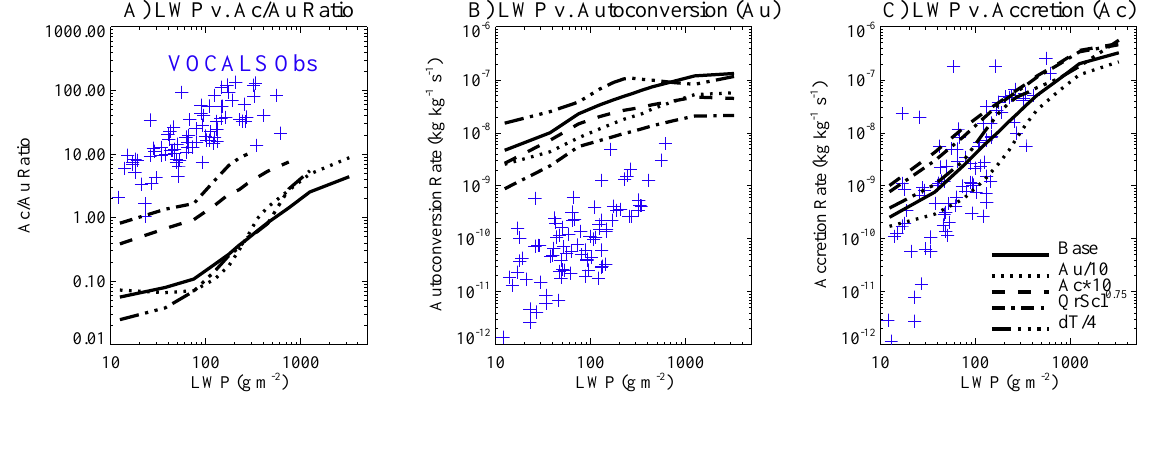
Figure 8. Global averages of vertically averaged (A) Accretion/Autoconversion ( A c /A u ) ratio v. LWP, (B) Autoconversion ( A u ) rate v. LWP and (C) Accretion ( A c ) rate v. LWP. Simulations are described in Table 2. Base CAM5 (solid), A u /10 (dotted), A c *10: (dashed), QrScl 0 . 75 (Dot Dashed) and d T/ 4 (triple dot-dash). Also shown are observational estimates (blue crosses) from VOCALS aircraft flights as described in the